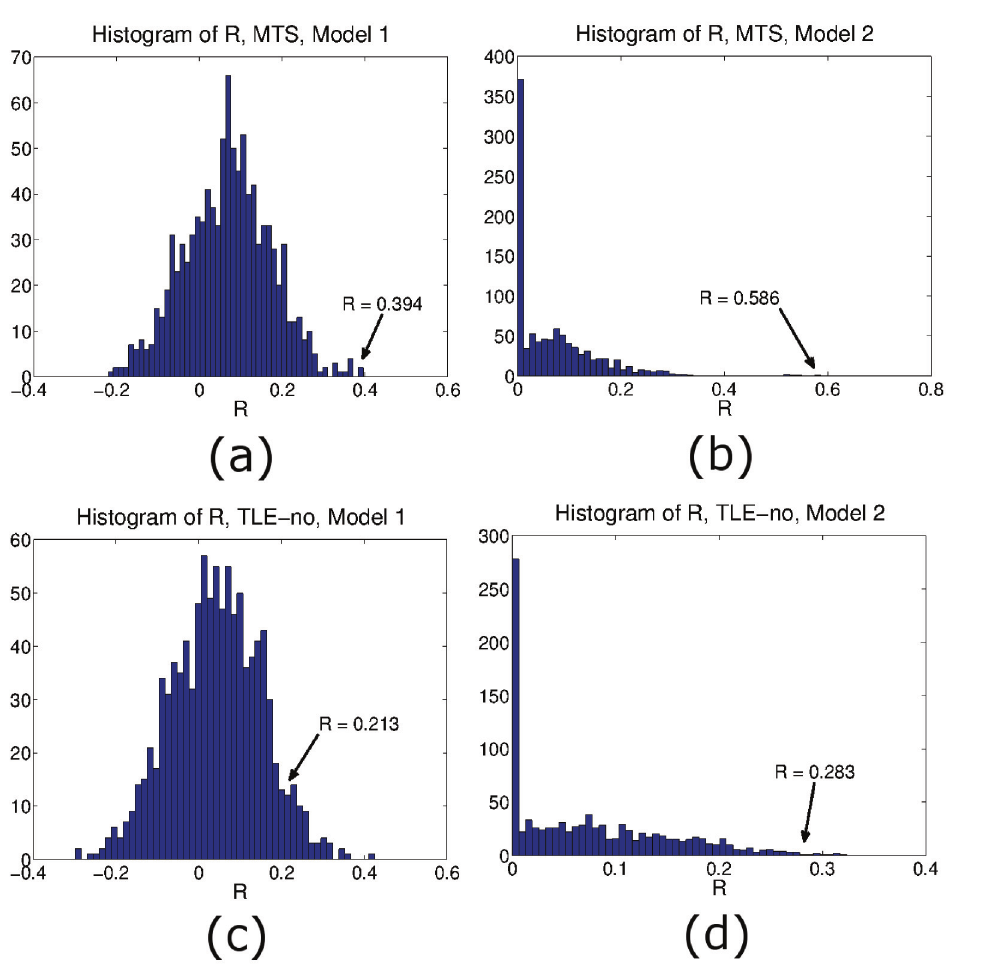
Fig 5. Histograms of R resulting from 1,000 instances of random permutations of the neuronal atrophy for each type of epilepsy and for both models. From the histograms, the estimated neuronal atrophy is likely to be specific to the atrophies obtained from both epilepsy groups, more so in the case of Model 2 where high R is obtained for both types of epilepsy. Histograms of R resulting from random permutation of neuronal atrophy, (a) TLE-MTS Model 1, (b) TLE-MTS, Model 2. Histogram of R resulting from TLE-no neuronal atrophy random permutation, (c) Model 1, and (d) Model